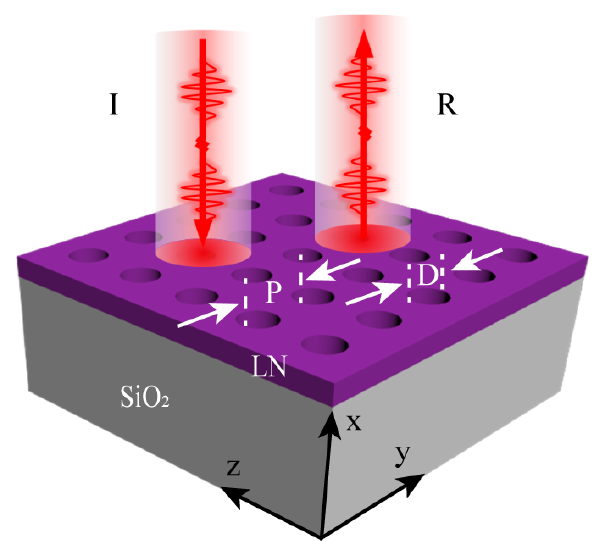
Figure 1. Schematic of the high-reflectivity metasurface based on x-cut LNOI comprising a square lattice of air holes, where P and D denote the period of the metasurface and the diameter of the air hole, respectively.